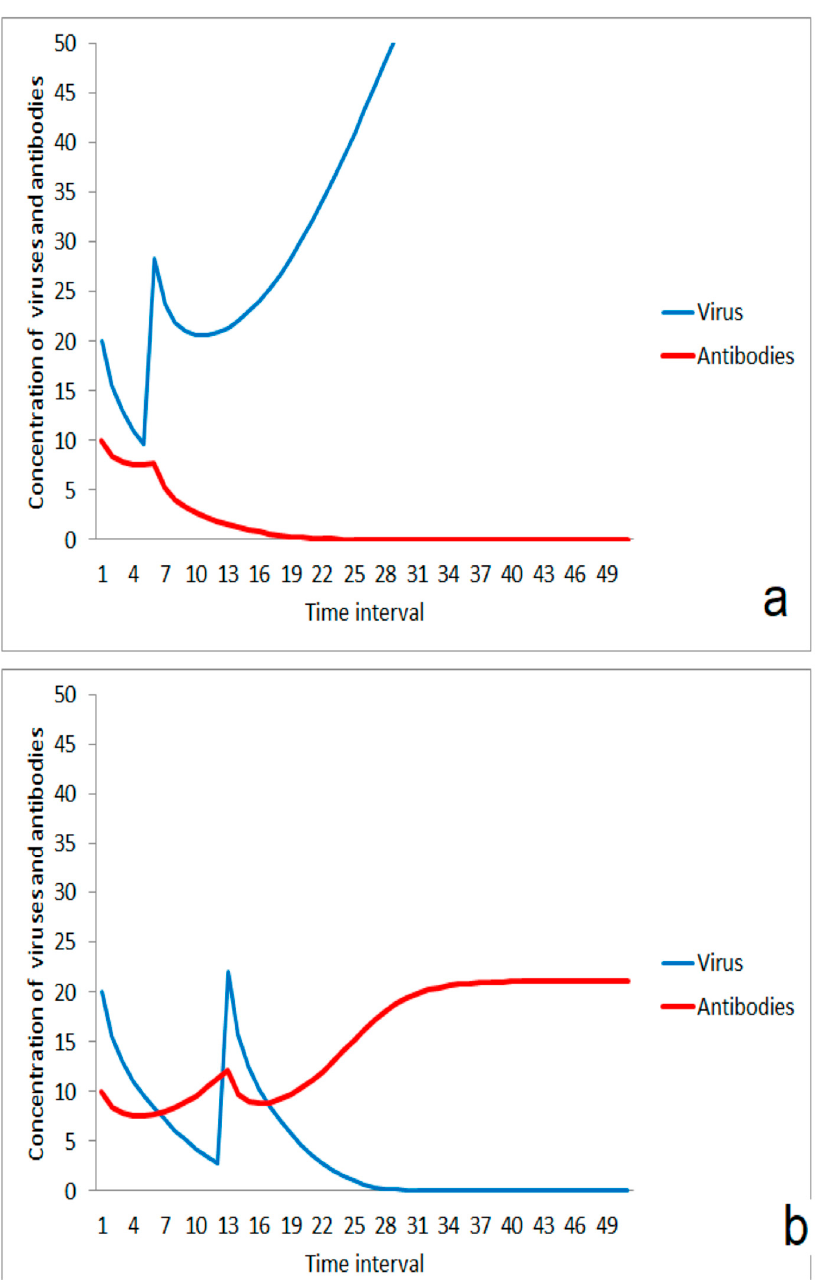
Figure 5. Role of the duration between first moderate virus impact and second impact: ( a ) outbreak of disease after a short time span between both impacts, ( b ) suppression of infection after a longer duration between both virus